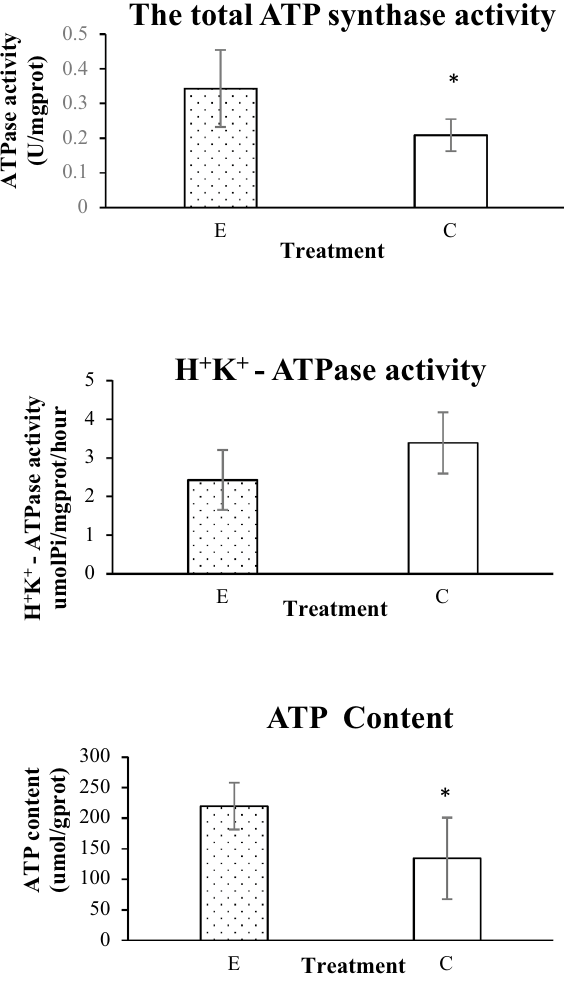
Figure 2. Changes of the total ATP synthase activity, H + K + -ATP synthase activity and ATP content (The control group mark was C and the electromagnetic radiation exposure group mark was E. Bars represent the SD of the mean, “*” represents p < 0.05, E relative to